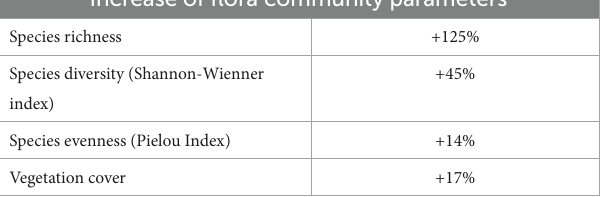
TABLE 2 Proportional increase of flora community parameters in the in-situ plots sown with the final seed mix. Increase of flora community